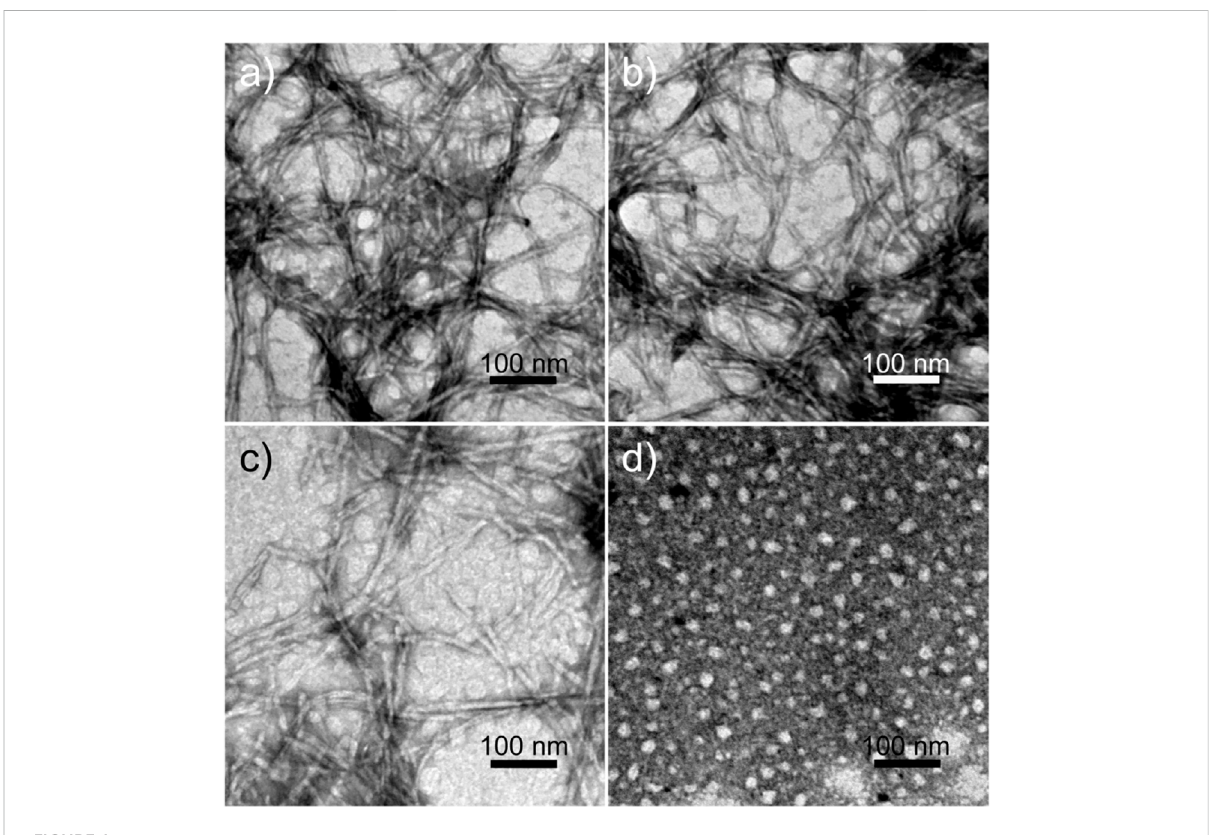
FIGURE 1 TEM images of nanostructures formed from 0.1 mM (A) RADA16H, (B) RADA16H 2 , (C) RADA16H 3 , and (D) RGDA16H 2 . The bar represents 100